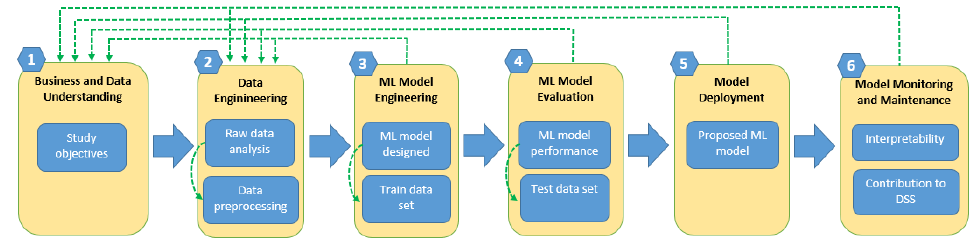
Figure 1. Representation of the CRISP-ML(Q) model of this